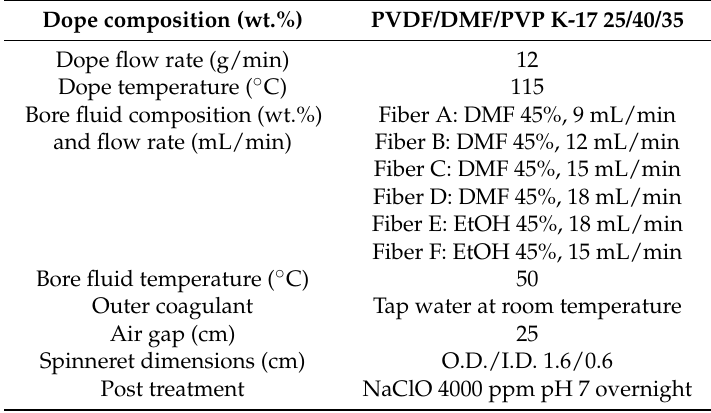
Table 1. Detailed spinning conditions of the poly(vinylidene fluoride) (PVDF) hollow fibers produced in this